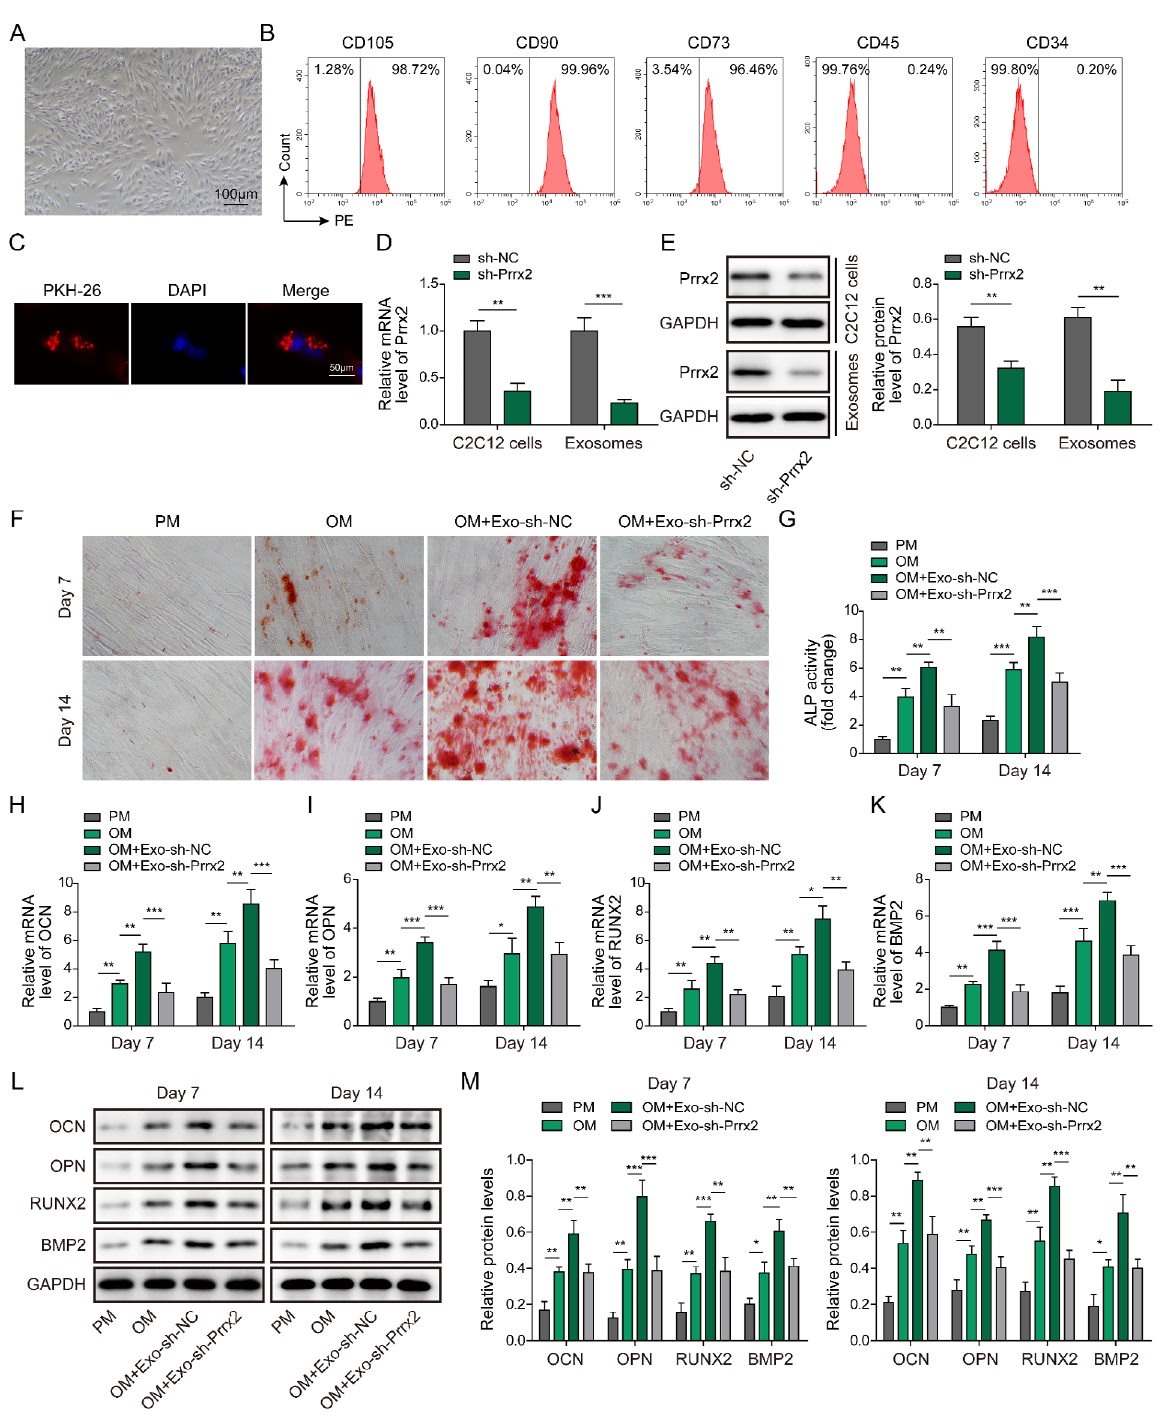
Fig. 2 Myoblast-derived exosomal Prrx-2 facilitates osteogenic differentiation of BMSCs. (A) Morphology of isolated mouse BMSCs. (B) Flow cytometry confirmed the positive expression of CD105, CD90, CD73, and negative expression of CD45 and CD34 in BMSCs. (C) The internalization of PKH26-labeled exosomes by BMSCs was observed under a fluorescence microscopy. The expression of Prrx-2 in exosomes derived from Prrx-2-silenced C2C12 myoblasts was assessed by qRT-PCR (D) and Western blotting (E). (F) The calcium deposition of BMSCs was measured using Alizarin Red staining in the prolifera- tion medium (PM), osteoblastic medium (OM), OM + Exo-shNC, OM + Exo-shPrrx-2 groups. (G) The ALP activity of BMSCs in the PM, OM, OM + Exo-shNC, OM + Exo-shPrrx-2 groups was determined. (H-M) qRT-PCR and Western blot analysis of the mRNA and protein levels of OCN, OPN, RUNX2, and BMP2 in the PM, OM, OM + Exo-shNC, OM + Exo-shPrrx-2 groups. * P < 0.05, ** P < 0.01 and *** P <